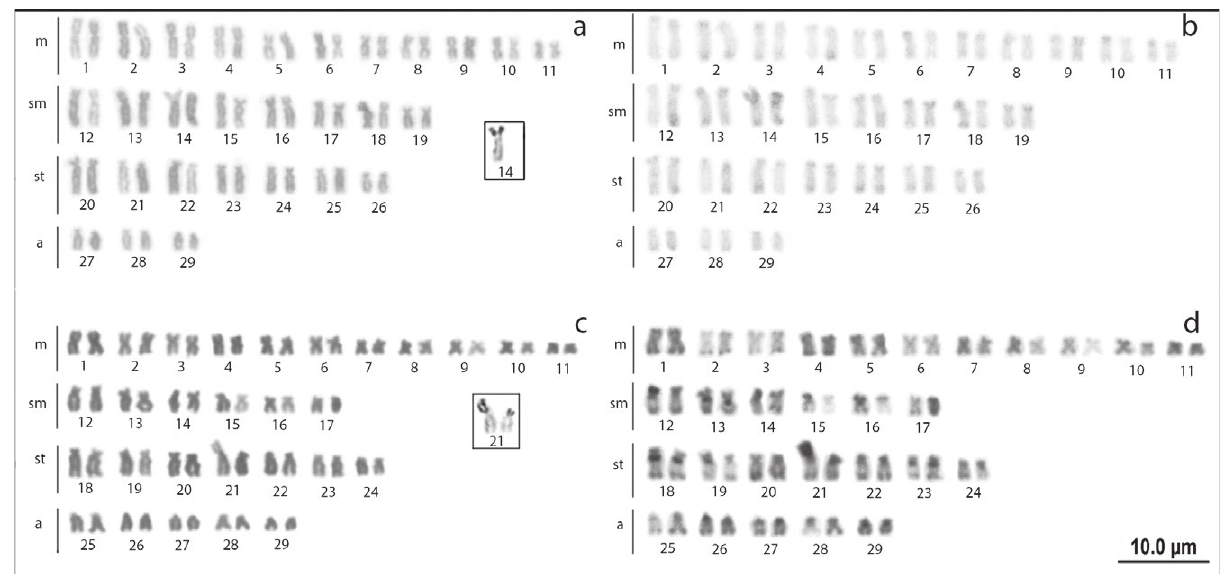
Figure 2. Karyotypes of Auchenipterus nuchalis ( a , b ) and Entomocorus radiosus ( c , d ) stained with Giemsa ( a , c ) and submitted to C-band- ing ( b , d ). AgNORs presented in boxes. The presence of only one marked chromosome (Fig 2a, in box) during the silver nitrate impregnation technique (AgNOR 3 ) in A. nuchalis suggests that the Nucleolus Organizer Region (NOR) on its corresponding chromosome was inactive during the previous interphase or even in due the region is